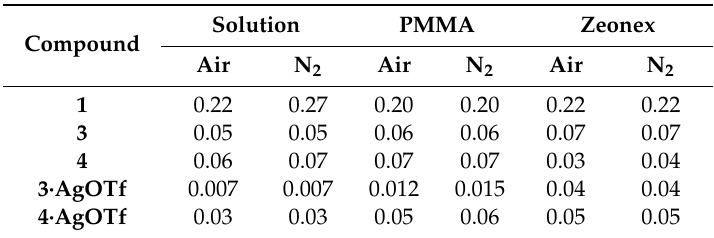
Table 2. Quantum yield values of 1 , 3 , and 4 in solution and in solid matrixes of poly methyl methacrylate (PMMA) and Zeonex.